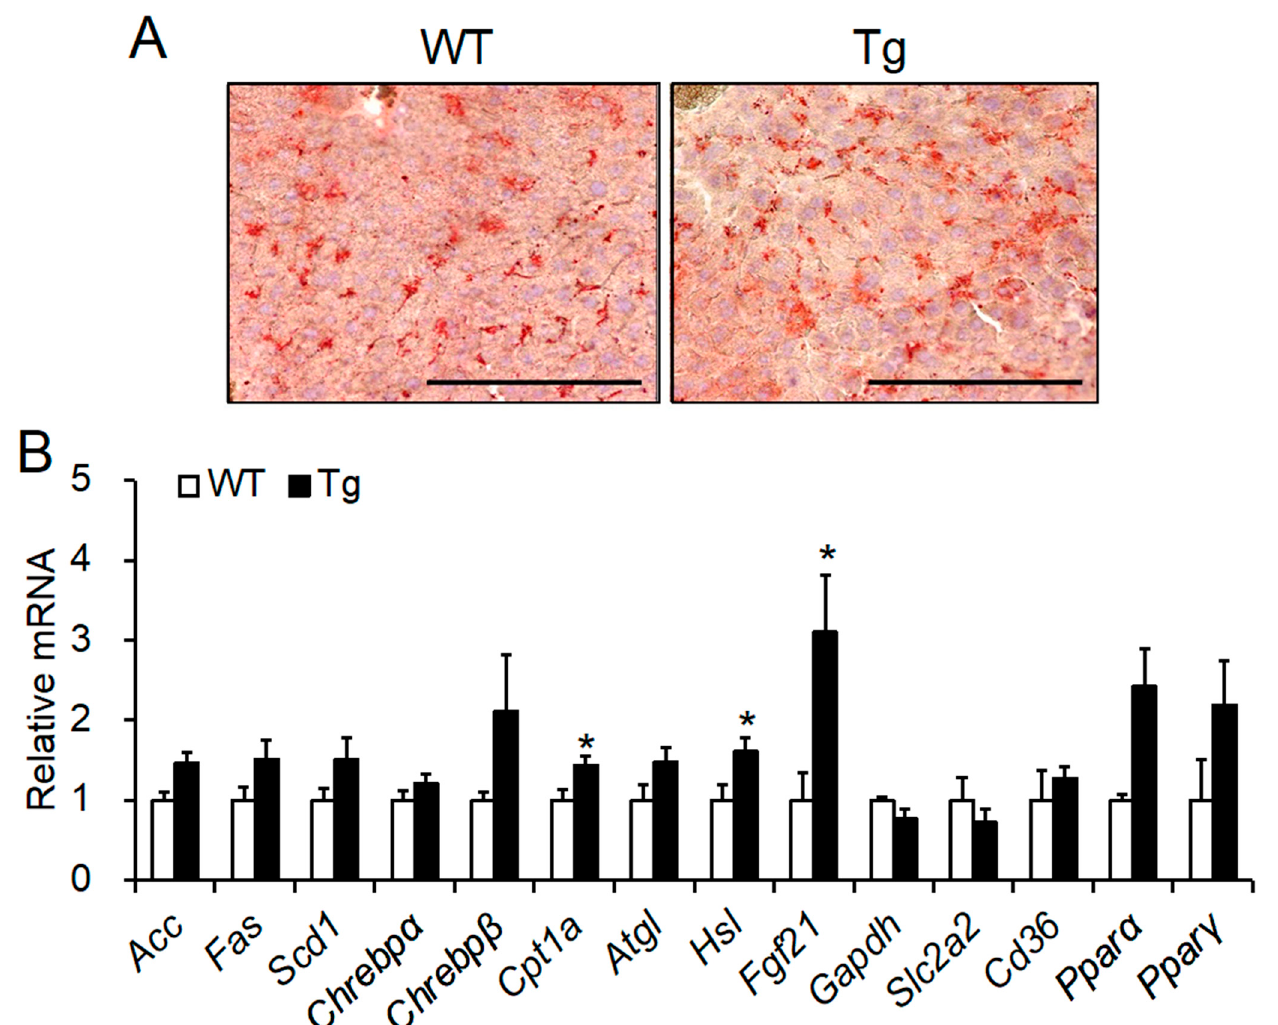
Figure 5. Morphological and mRNA expression analyses of the liver of Npgl Tg mice. ( A ) Oil red O staining of the liver sections. Red dots show lipid droplets. Scale bars = 100 μ m. ( B ) The expression levels of mRNA for lipid metabolism-related genes in the liver. All statistical analyses were performed using Mann-Whitney U test. Each value represents the mean ± SEM ( n = 5–8). Asterisks indicate statistically significant differences (* p < 0.05). Npgl , neurosecretory protein GL; WT, wild-type; Tg, transgenic.